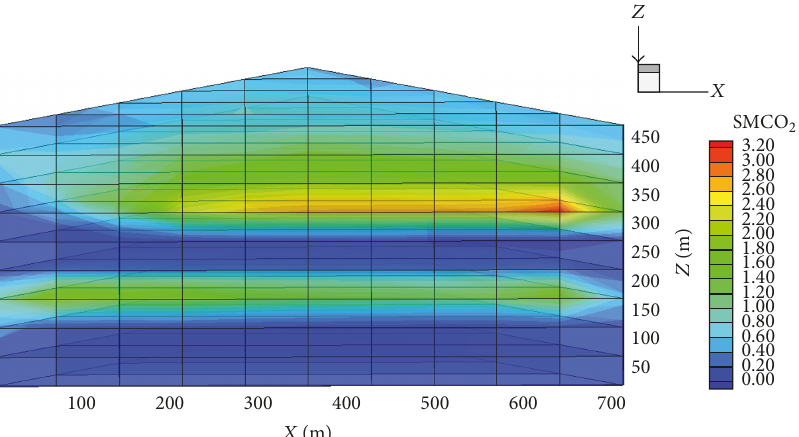
Figure 7: Simulated 3D profile of cumulative CO 2 sequestered (kg/m 3 ) by carbonate mineral precipitation after 30-year injection of scCO 2 as a working